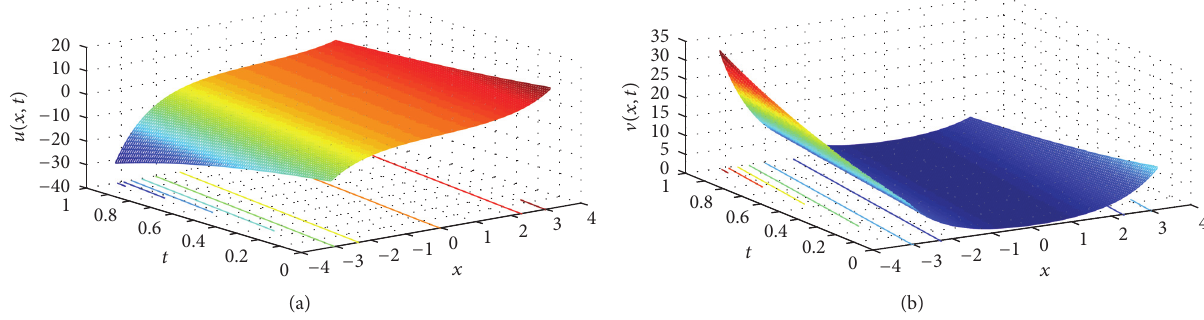
Figure 1: Behavior of 𝑢 (a) and V (b) of initial value system (8) in (−𝜋,𝜋) .